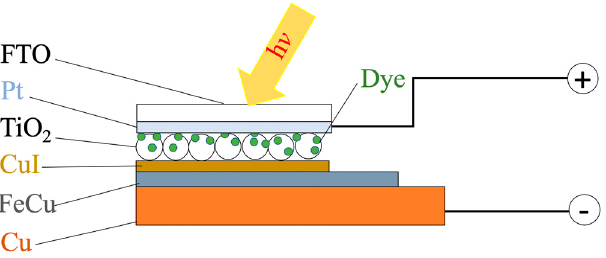
Figure 3. The assembled device (solar cell), featuring the Cu/FeCu/CuI electrode.